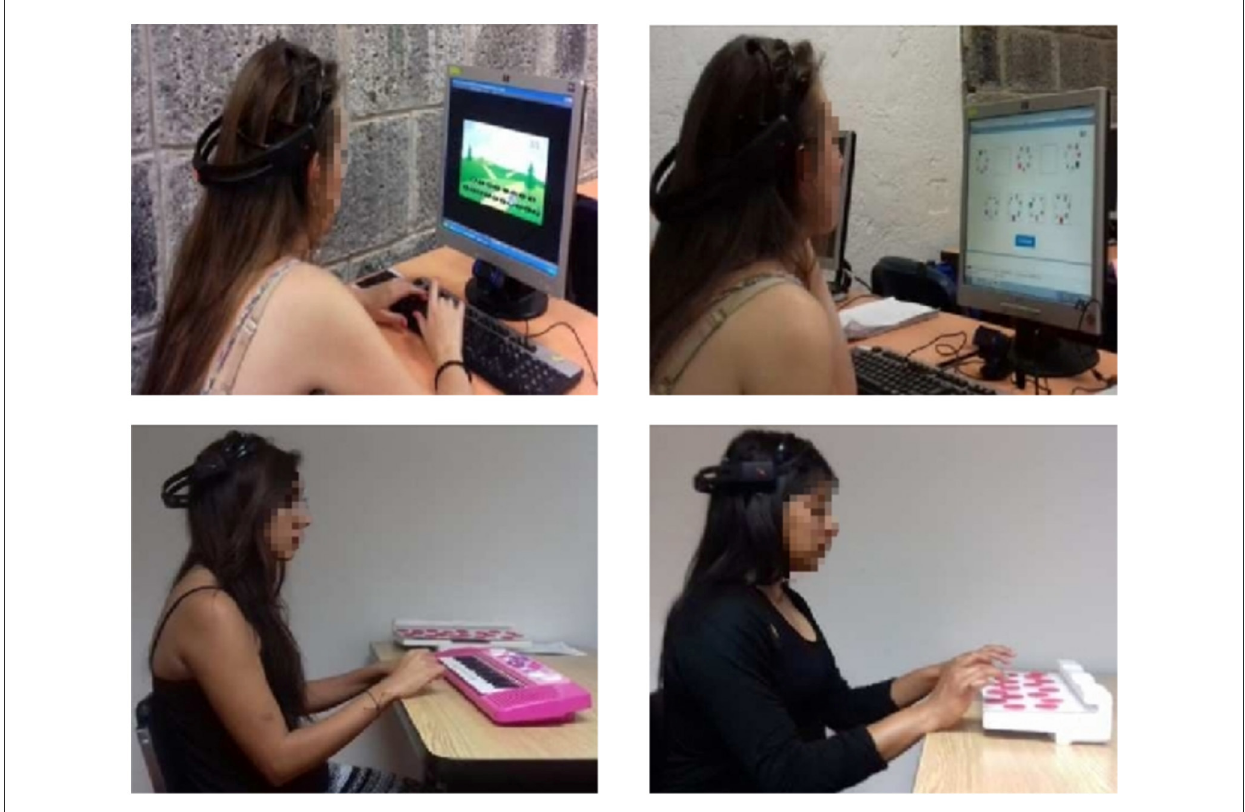
FIGURE2 Training in the virtual (top) and real (bottom) environments.